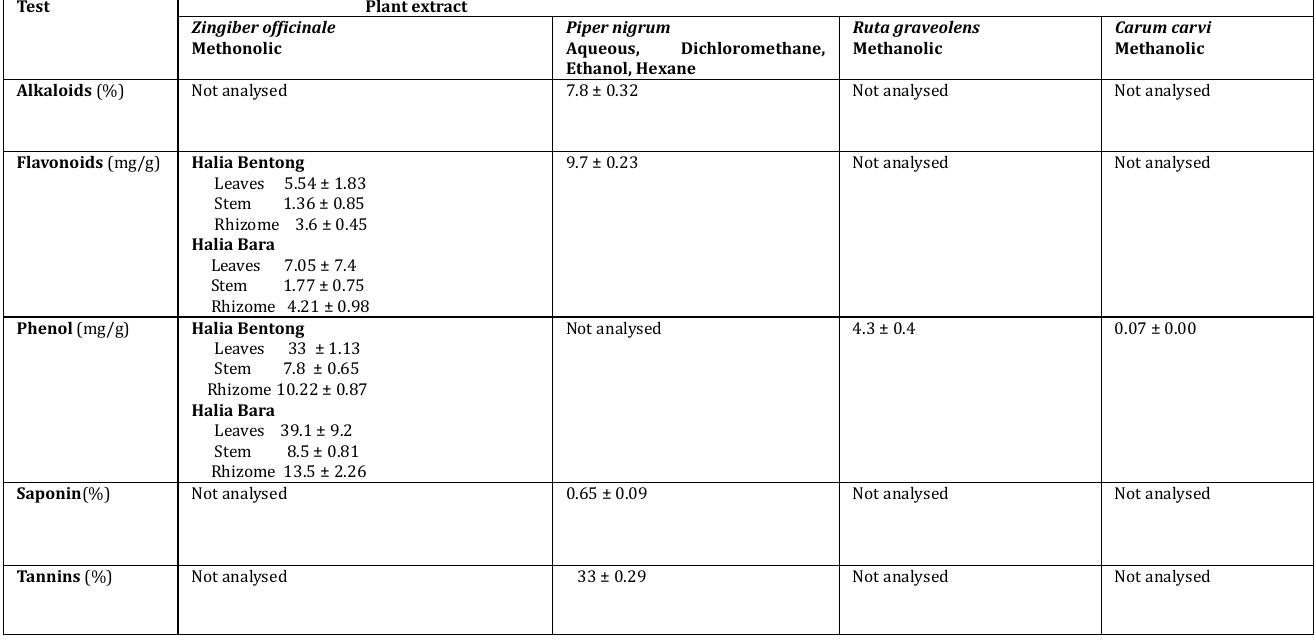
Table 2: Quantitative analysis of plant